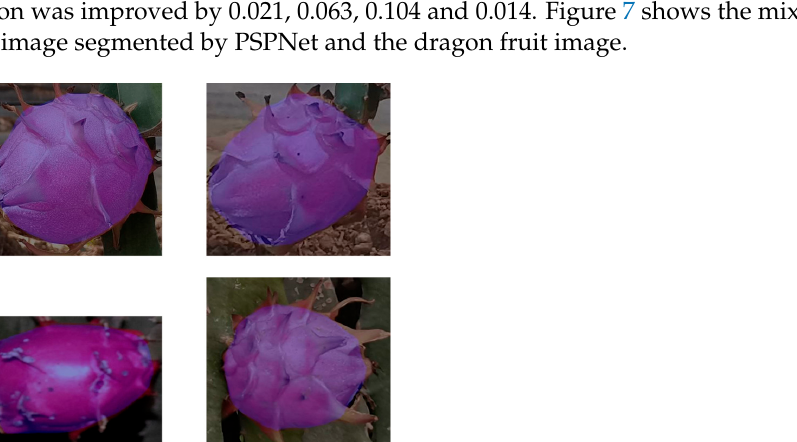
Figure 7. The mixing results of the image segmented by PSPNet and the dragon fruit